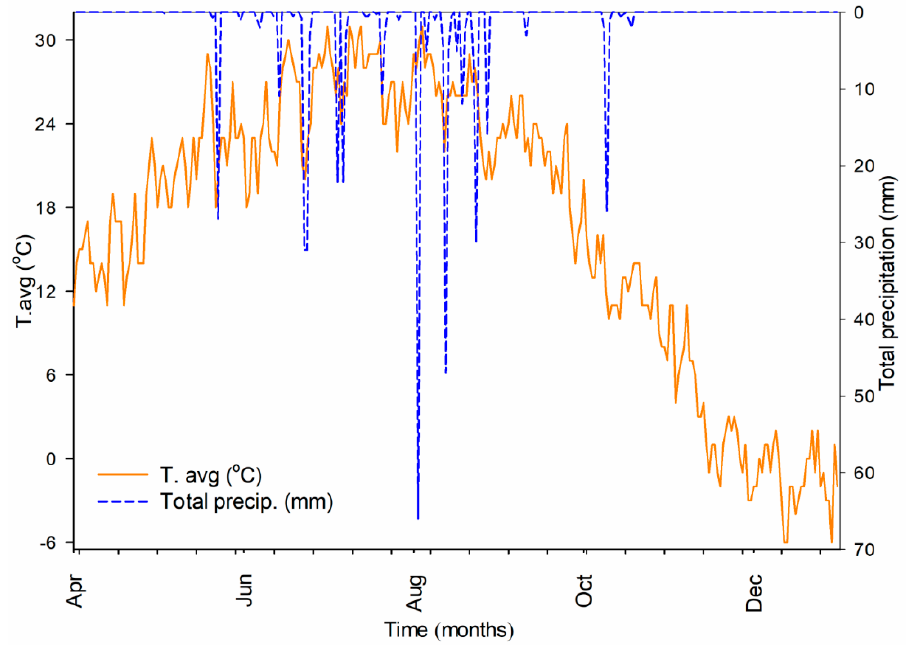
Figure 1. Daily mean temperature and precipitation data during the two cropping seasons.